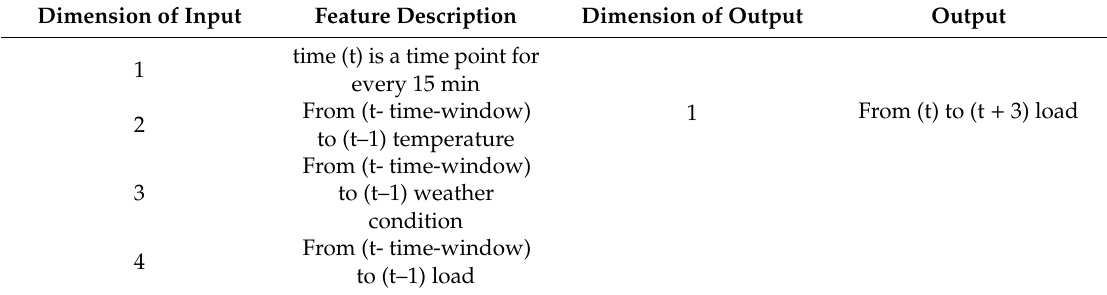
Table 1. Input and output.